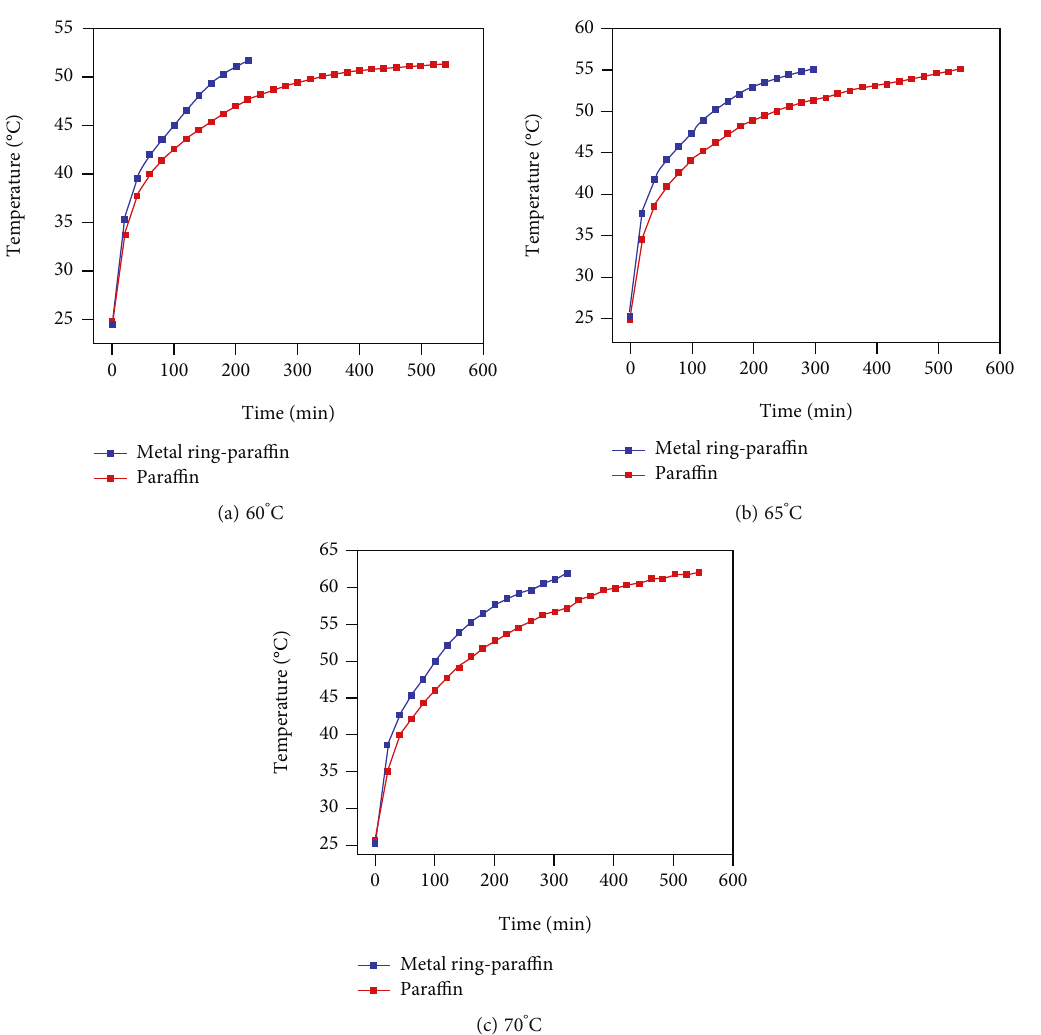
Figure 11: Average heat storage device temp change under the condition of various heat source temperatures as well as fi lling materials.